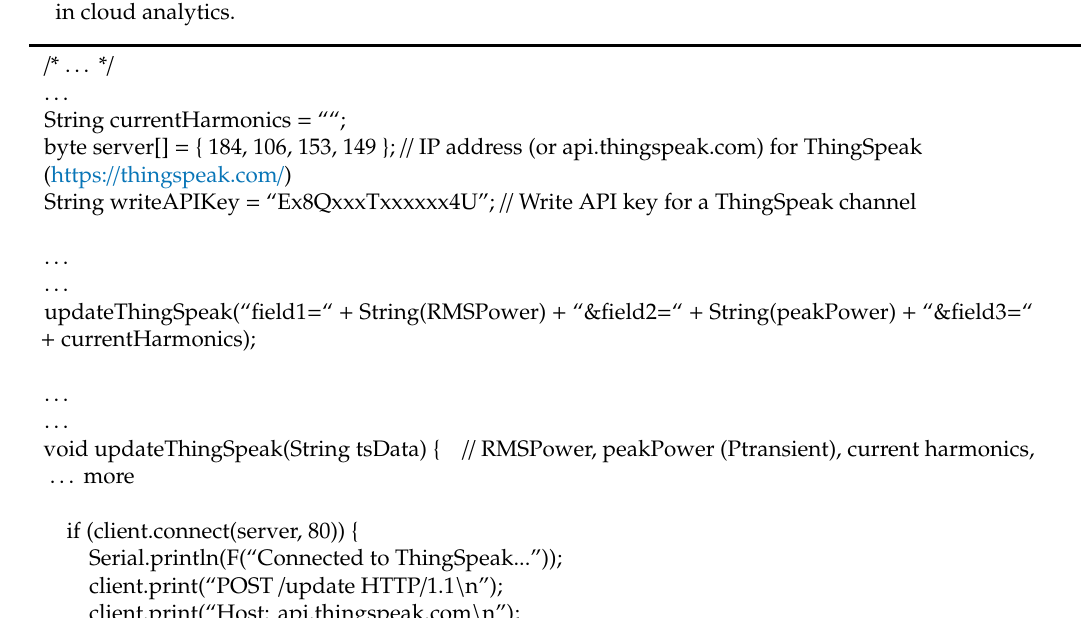
Table 4. Code executed by the developed smart autonomous power meter prototype and used to upload (transmit) extracted electrical features to the ThingSpeak ™ cloud for data storage to be further analyzed in cloud